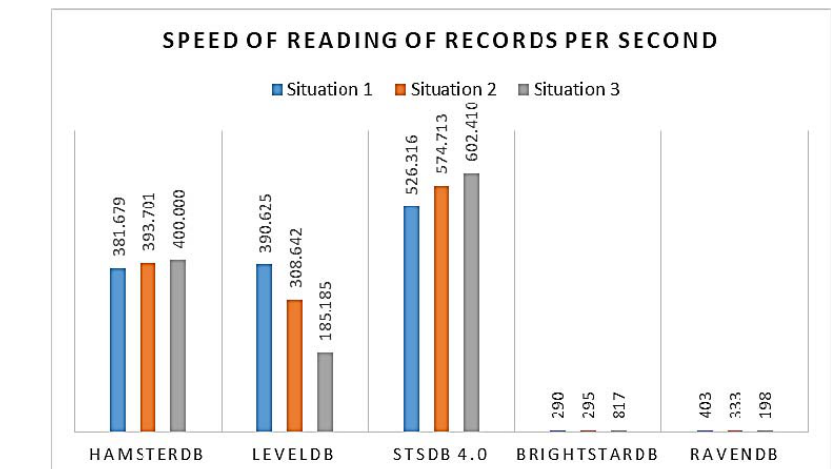
Figure 7 – Speed of reading of records per second Рисунок 7 – Скорость чтения записей в секунду